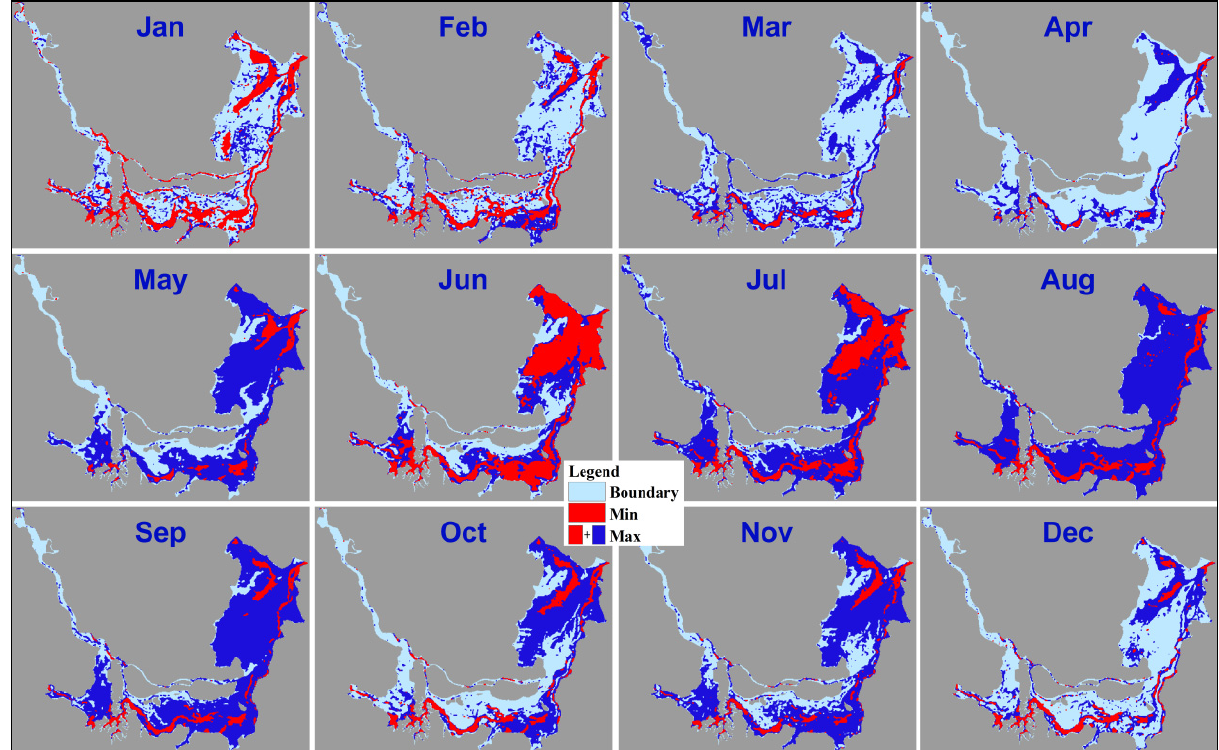
Figure 5. Variations in minimum and maximum inundation areas derived from MODIS images in each month during 2000 to 2012 in the Dongting